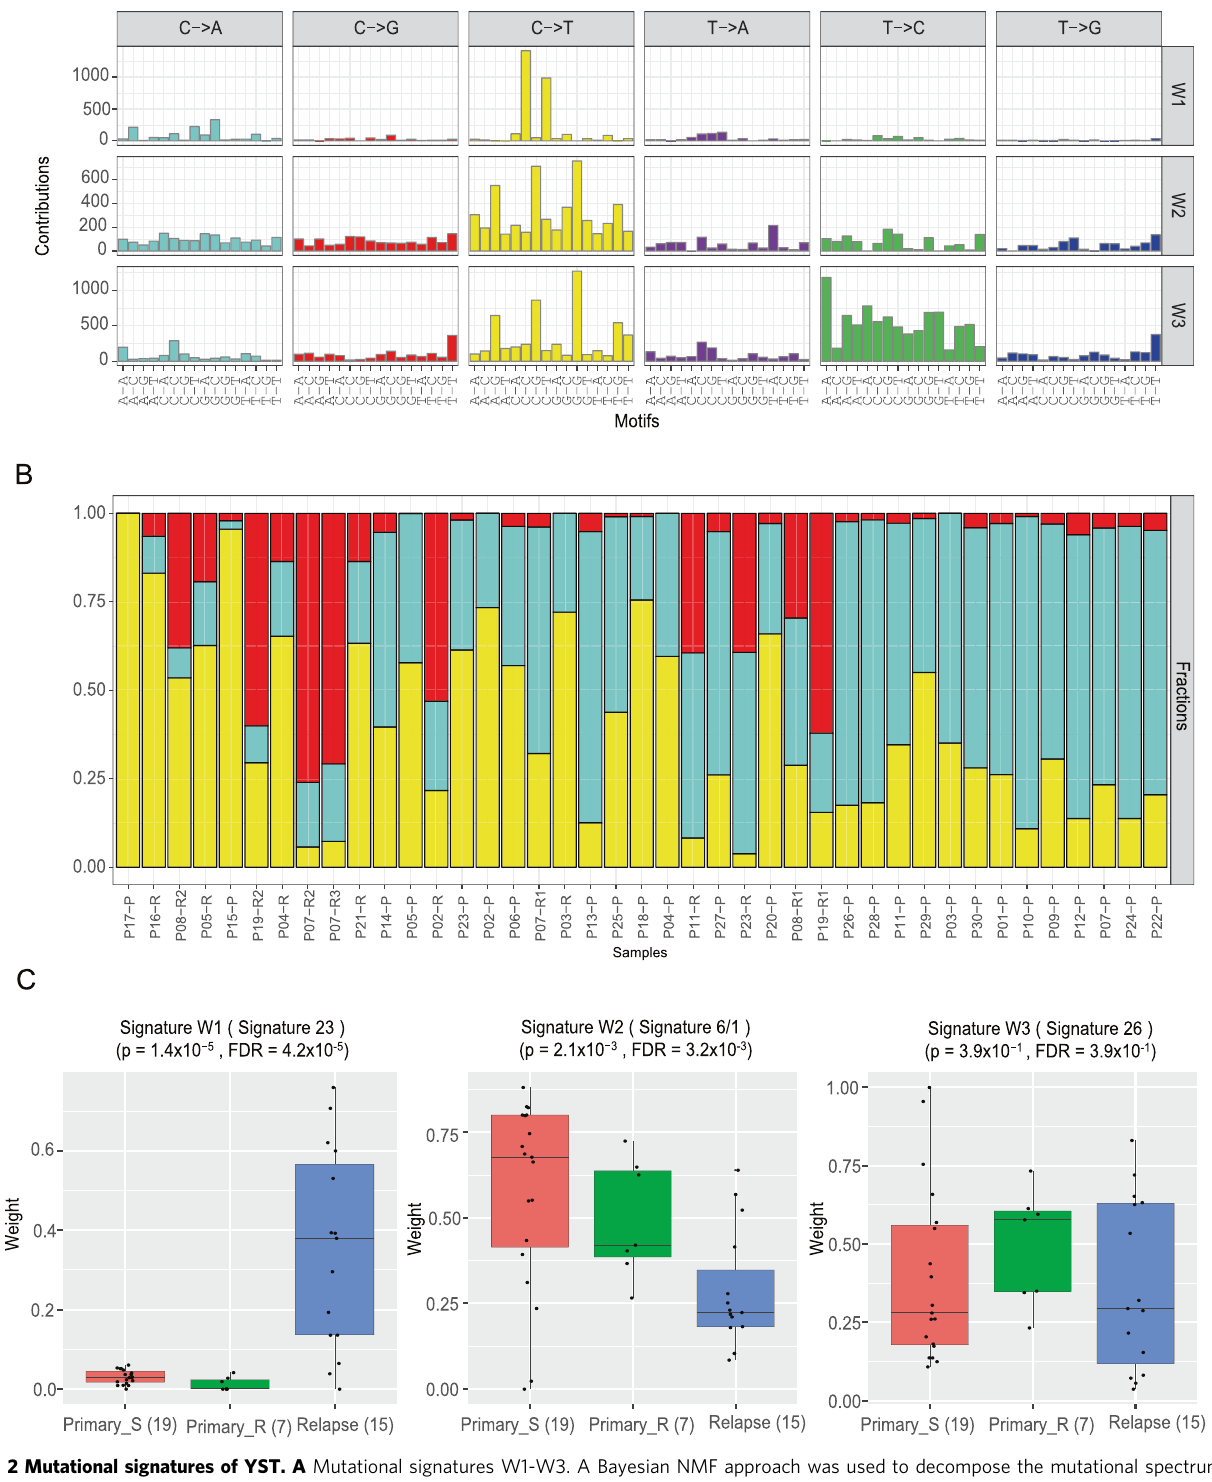
Fig. 2 Mutational signatures of YST. A Mutational signatures W1-W3. A Bayesian NMF approach was used to decompose the mutational spectrum across the 41 YST tumor samples into distinct mutational signatures. Each color refers to one of the six base substitutions, each of which is further strati fi ed by the adjacent 5 ′ and 3 ′ fl anking nucleotides. B The relative contributions of mutational signatures in each tumor sample. C The comparison of each signature among chemo-sensitive primary, chemo-resistant primary, and relapsed samples. P values were computed based on Kruskal – Wallis tests (primary_sensitive: n = 19 biologically independent samples; primary_resistant: n = 7; relapse: n = 15), and FDR were used for multiple testing corrections. The middle line in the box is the median, the bottom and top of the box are the fi rst and third quartiles, and the whiskers extend to 1.5× interquartile range of the lower and the upper quartiles,